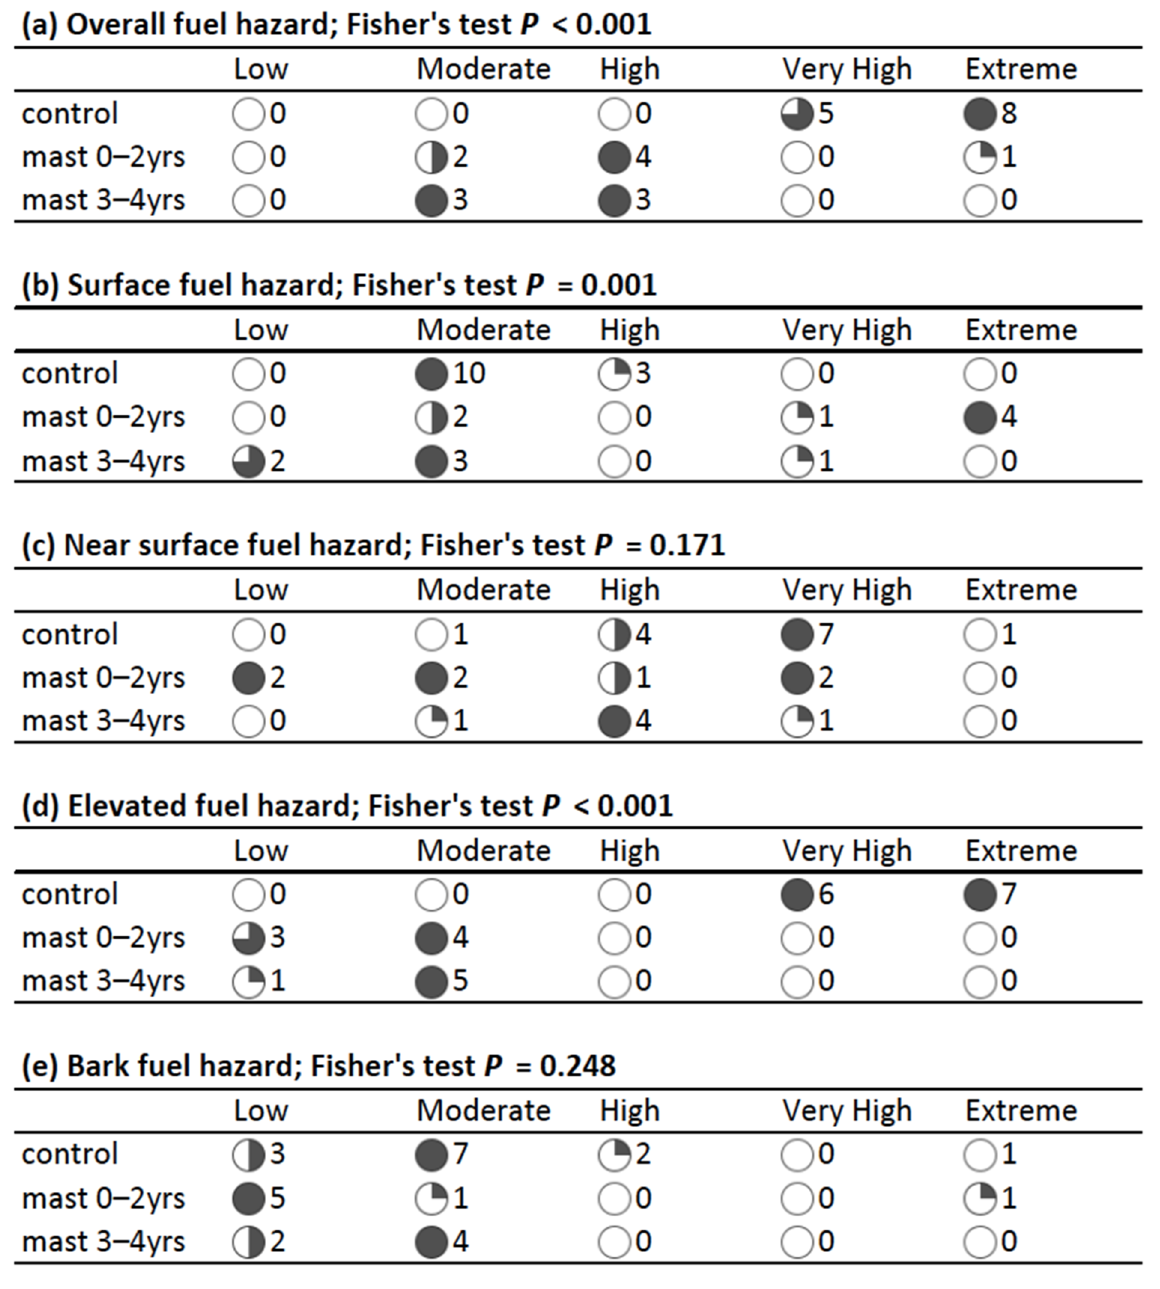
Figure 5. Contingency tables showing the number of times each fuel hazard category was recorded in each treatment for ( a ) Overall fuel hazard; ( b ) Surface fuel hazard; ( c ) Near-surface fuel hazard; ( d ) Elevated fuel hazard; and ( e ) Bark fuel hazard. Pie charts provide a visual indicator of the relative frequency of occurrence of each hazard class within a treatment class.